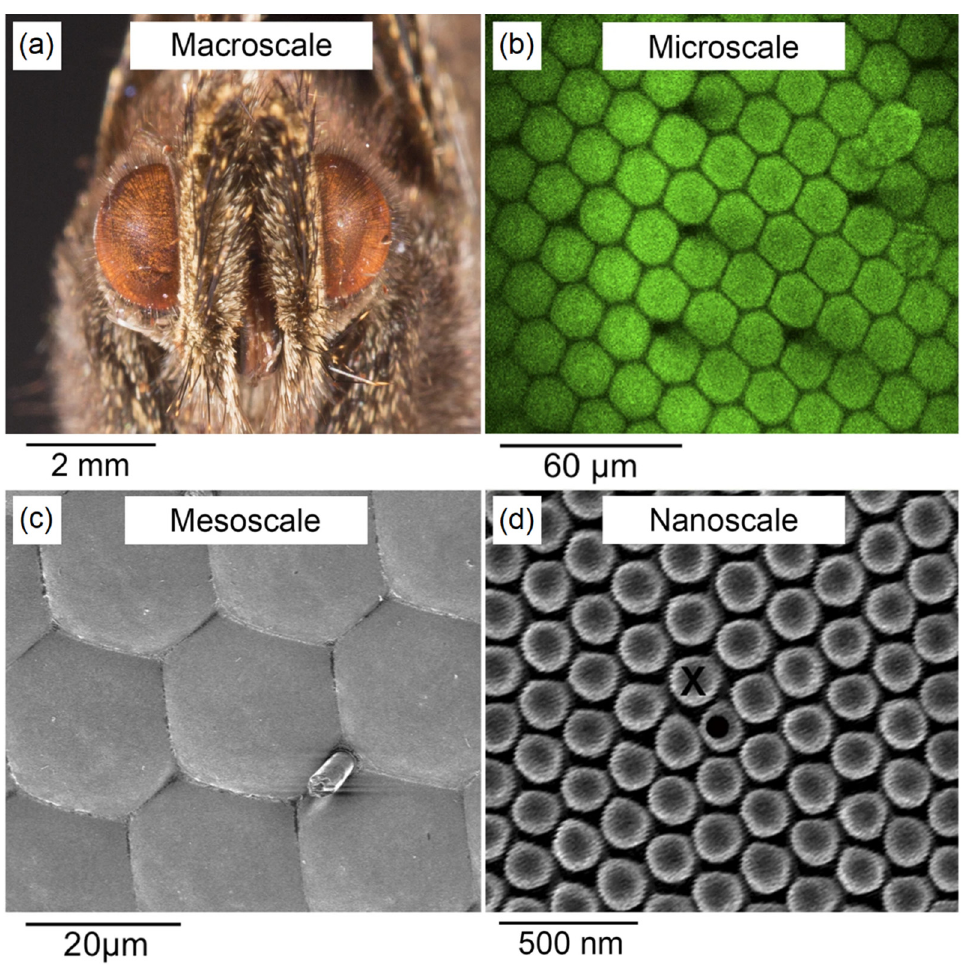
Figure 4. Structure of the eye of a Mourning Cloak butterfly (Nymphalis Antiopa) on different length scales. ( a ) Macroscale. ( b ) Microscale. The hexagonal close-packed pattern is clearly visible. ( c ) Mesoscale. Each hexagon of the pattern is around 20 µm wide. ( d ) Nanoscale. The average nipple diameter is 170 nm. Adapted with permission from Ref. [34]. 2016, license CC BY